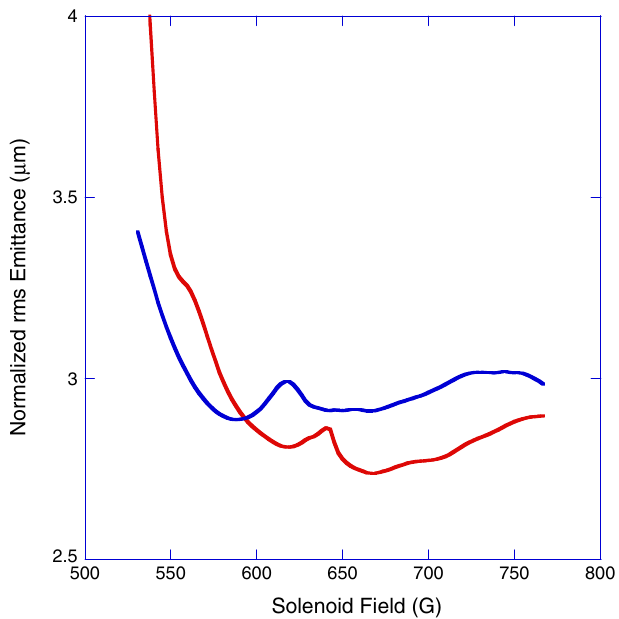
FIG. 2. Plots of calculated normalized rms emittance versus solenoid field at 9 MV = m (blue) and 10 MV = m (red) cathode